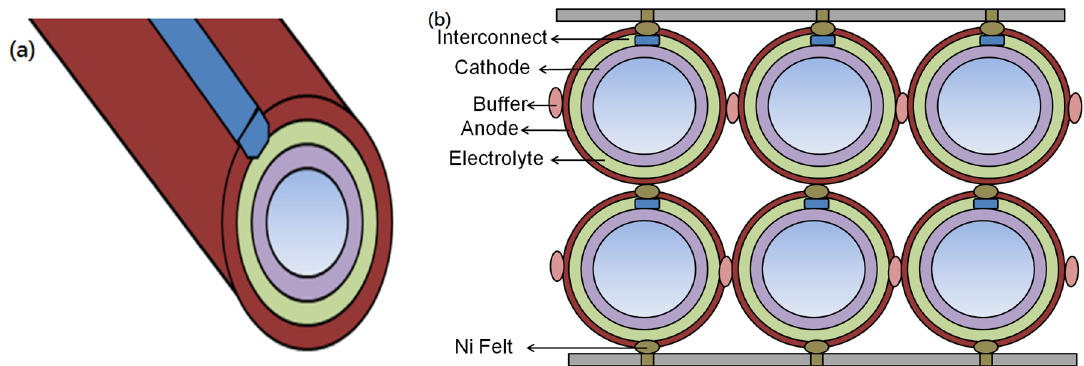
Figure 6. Schematic of typical tubular Solid Oxide Fuel Cell ( a ) Single tubular SOFC; ( b ) Stack of tubular SOFCs.